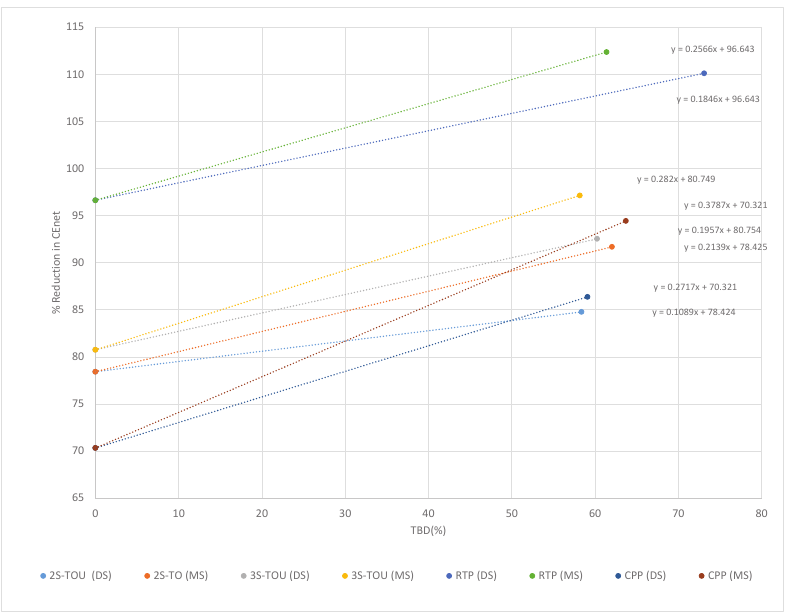
Figure 33. Tradeoffs between CEnet and TBD for PDDR-RED-based HEMS.